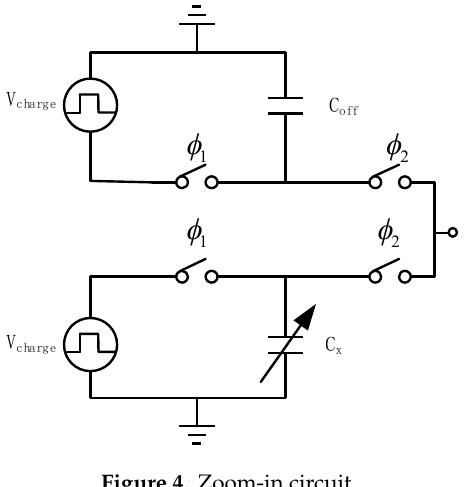
Figure 4. Zoom-in circuit.